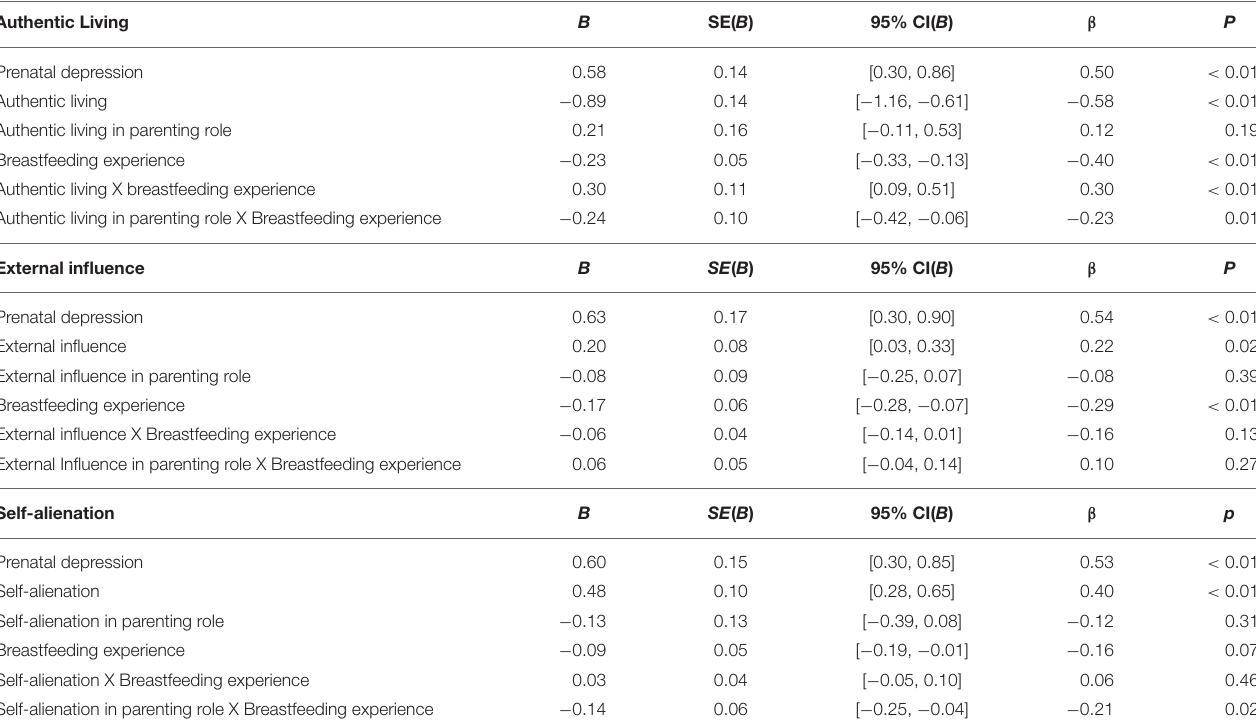
TABLE 3 | Results of regression analyses predicting maternal postpartum depressive symptoms from facets of authenticity and breastfeeding experience. Authentic